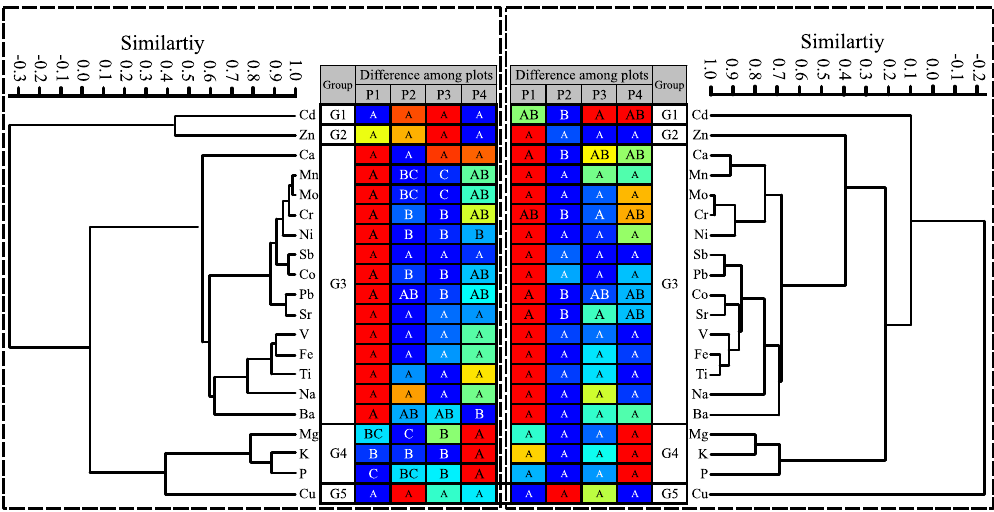
Figure 3. Dendrograms obtained using UPGMA cluster analysis on the correlation distance matrix, and table showing elemental concentration differences among plots for CAf ( a ) and PHh ( b ). The broken line in the dendrogram shows a correlation similarity of 0.55. In the Difference among plots rows, different capitalised letters in a row denote a significant difference in element concentration among plots. Different background colours in each row are the heatmap showing range-standardised concentrations. P1, P2, P3 and P4 denote plots with a distance to the road of 5–10 m, 100 m, 200 m and 400 m, respectively. Cluster analysis was performed on the raw concentrations, and the resultant cophenetic correlation index was 0.921 for CAf and 0.919 for PHh. Concentration differences between plots were evaluated using Paired-samples T tests followed by a Bonferroni correction ( α = 0.0085). The heatmap was produced using Past 3.14 software (Ø. Hammer, Sep. 2016). CAf refers to Candelaria fibrosa (n = 12). PHh refers to Phaeophyscia hirtuosa (n =